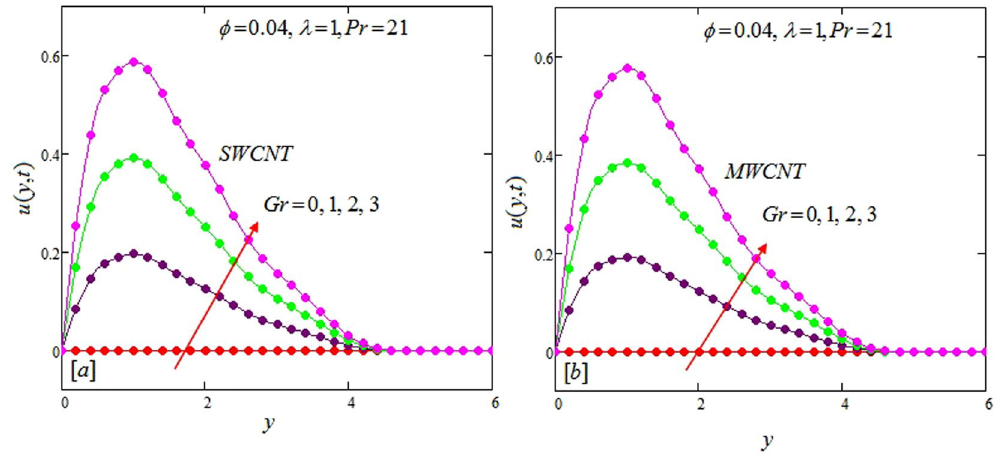
on heat transfer rate. Table 3 shows rate of heat transfer for SWCNT and MWCNT for different values of volume fraction φ . The enhancement of heat transfer rate can be seen from the table, heat transfer rate increases with increasing volume fraction of nanoparticles which was our main target because the purpose of adding nanopar- ticles to our working fluid is to enhance its rate of heat transfer and to make it useful for the practical purpose.